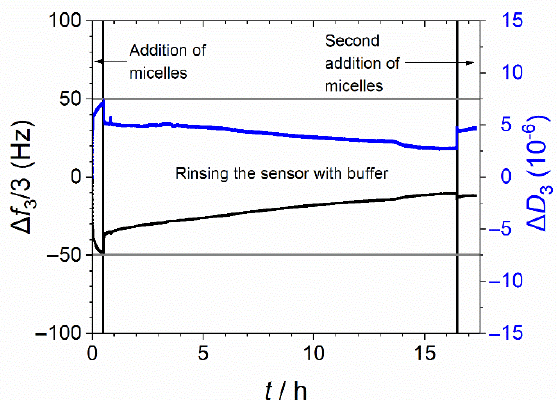
Figure 6. Application of DSPE-PEG2000 micelles on a silica sensor followed by an extended period of rinsing the sensor with buffer solution. Subsequent the micelle solution is inserted again and the interaction between the sensor and the micelles is measured. The vertical black reference lines indicate the start of the rinsing ( t = 0.5 h) and the second injection of the micelles solution ( t = 16.5 h). The grey horizontal lines indicate the maximum dissipation and minimum frequency shift after the first application of micelles. T = 21 ◦